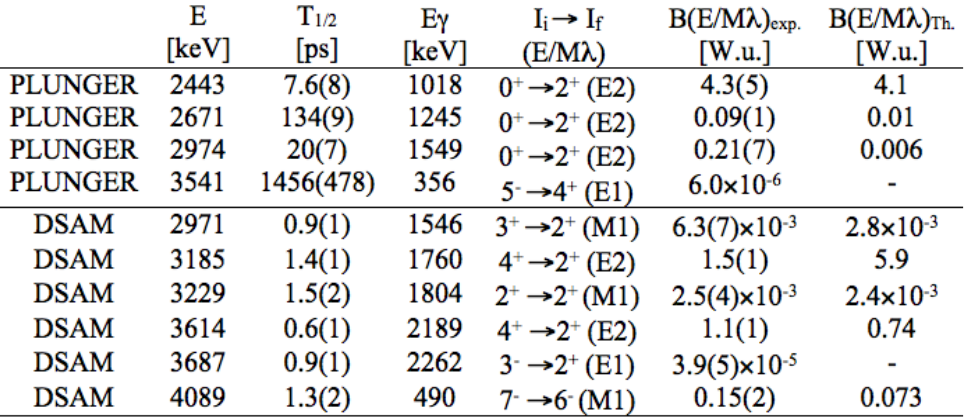
with theory predictions from MCSM [17].